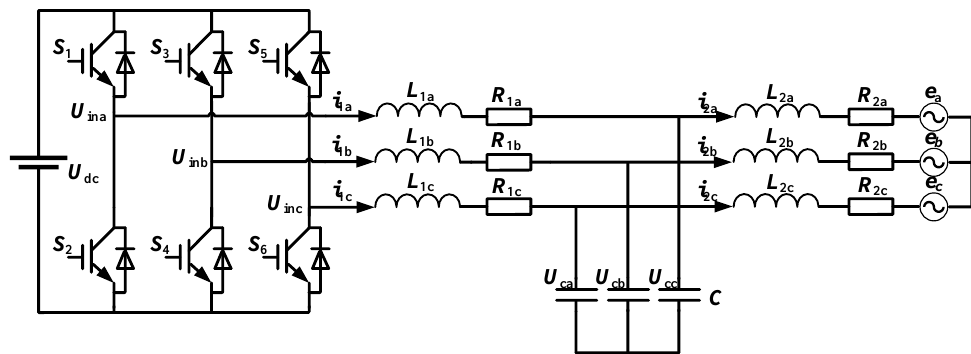
Figure 1. Topology of a three-phase LCL-type grid-connected inverter.